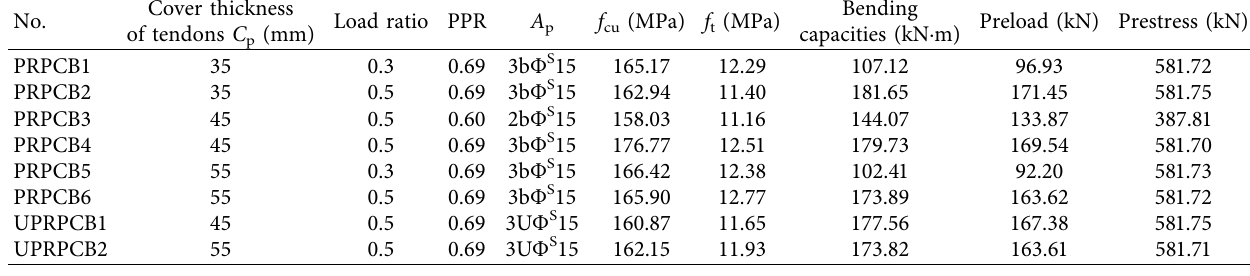
Table 1: Parameters of specimens.